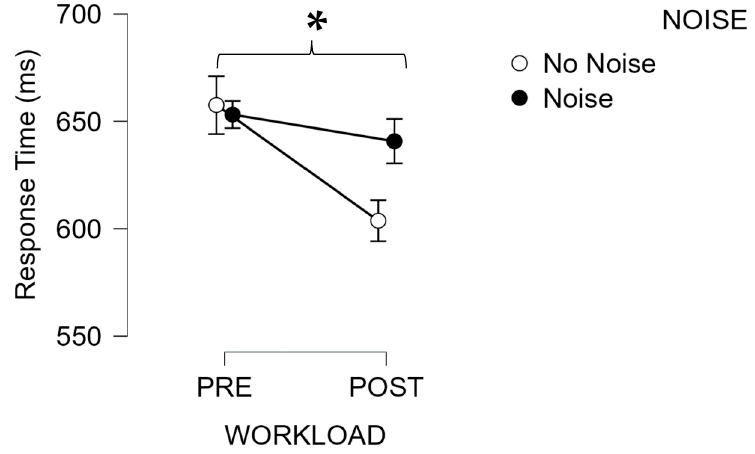
Figure 3. Response times (ms) of simple response time (SRT) and choice response time (CRT) tasks combined, without (No Noise) and with noise (Noise), before (PRE) and after (POST) the workload. * represents significant difference at p < 0.05, and bars represent standard errors.